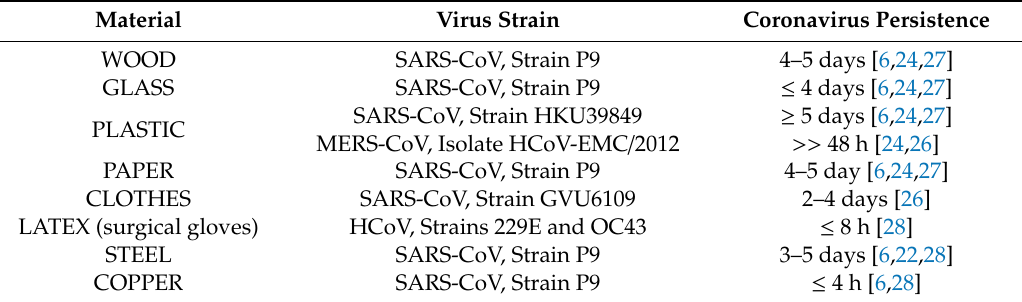
Table 1. Persistence of SARS-CoV-2 on di ff erent